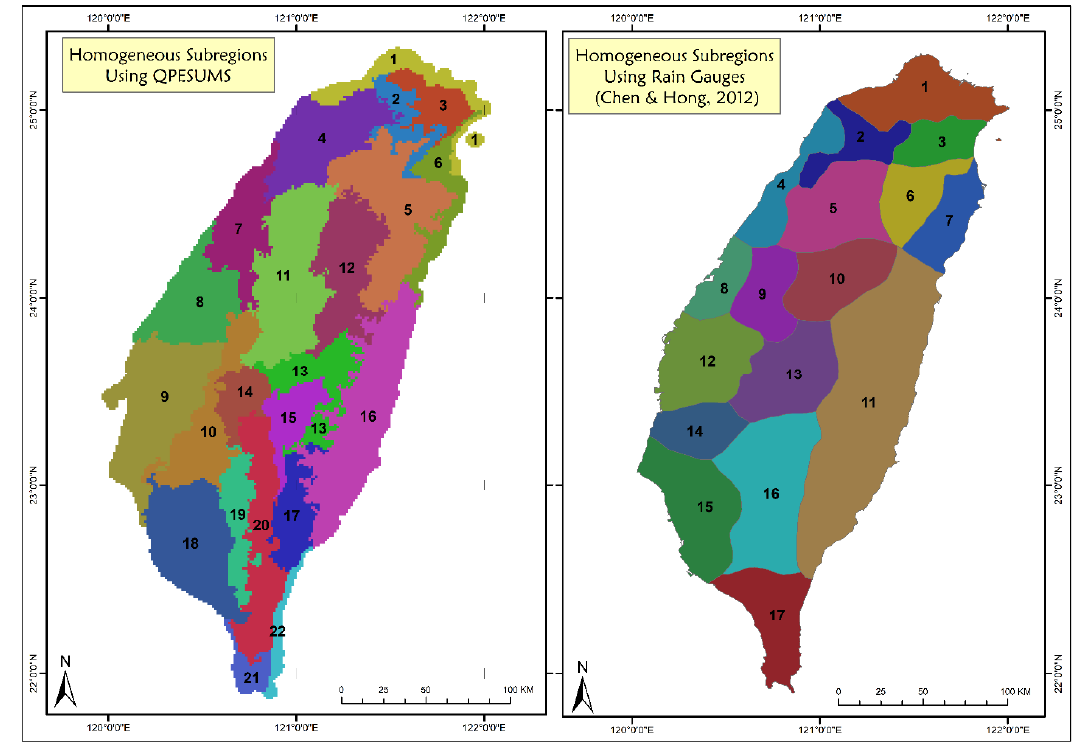
Figure 6. The division of 22 homogeneous subregions using QPESUMS in Comparison with Chen and Hong, (2012) [48]’s homogeneous subregions using Rain Gauges in Taiwan. Geographically, the 22 sub ‐ regions are divided into five regions: the northern region (sub ‐ regions 1–6), the western region (sub ‐ regions 7–10), the center region (sub ‐ regions 11–15), the eastern region (sub ‐ regions 16 and 17), and the southern region (sub ‐ region 18–22). Table 1 shows the total number of grids in each sub ‐ region, as well as their L ‐ moment ratio. According to Table 1, the biggest sub ‐ region is sub ‐ region 16, which is lo ‐ cated in the eastern region and has a total grid of 2231 grids, whilst the smallest sub ‐ region is sub ‐ region 22, which is located in the southern region and has a total grid of 248 grids. In contrast, the northern and southern areas of Taiwan have complicated distribution pat ‐ terns of homogenous sub ‐ regions. The results of heterogeneity tests for annual rainfall data are also summarized in Table 1. It can be seen that all regions are “acceptably homo ‐ geneous”, with H < 1. These results demonstrate that the 22 regions are sufficiently homo ‐ geneous. Table 1. L ‐ moment ratios and heterogeneity measure of 22 subregions.